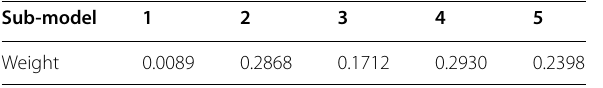
Table 5 Optimized weights.